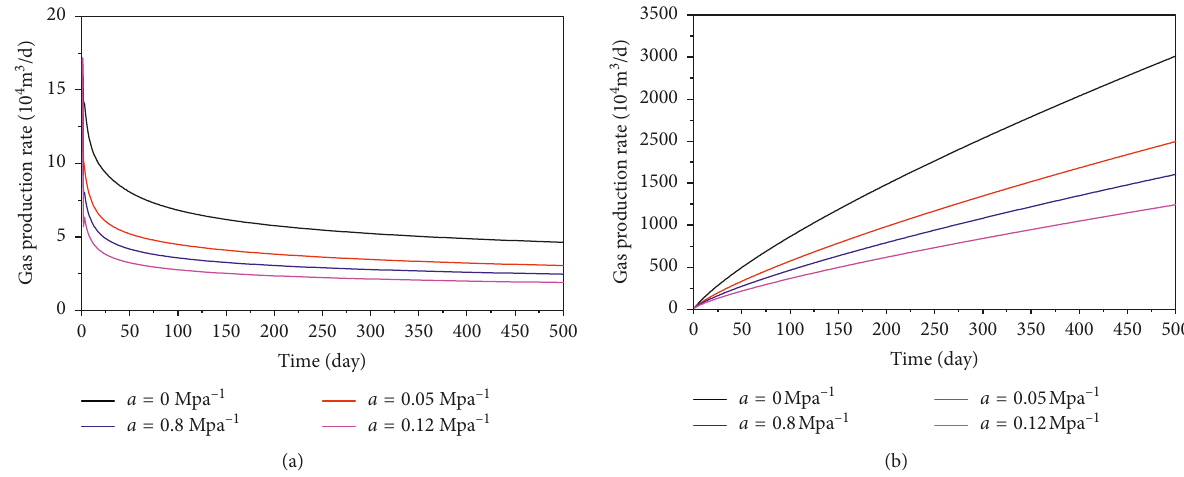
Figure 13: The behavior of the multistage fractured horizontal well: (a) gas production rate; (b) cumulative gas production.